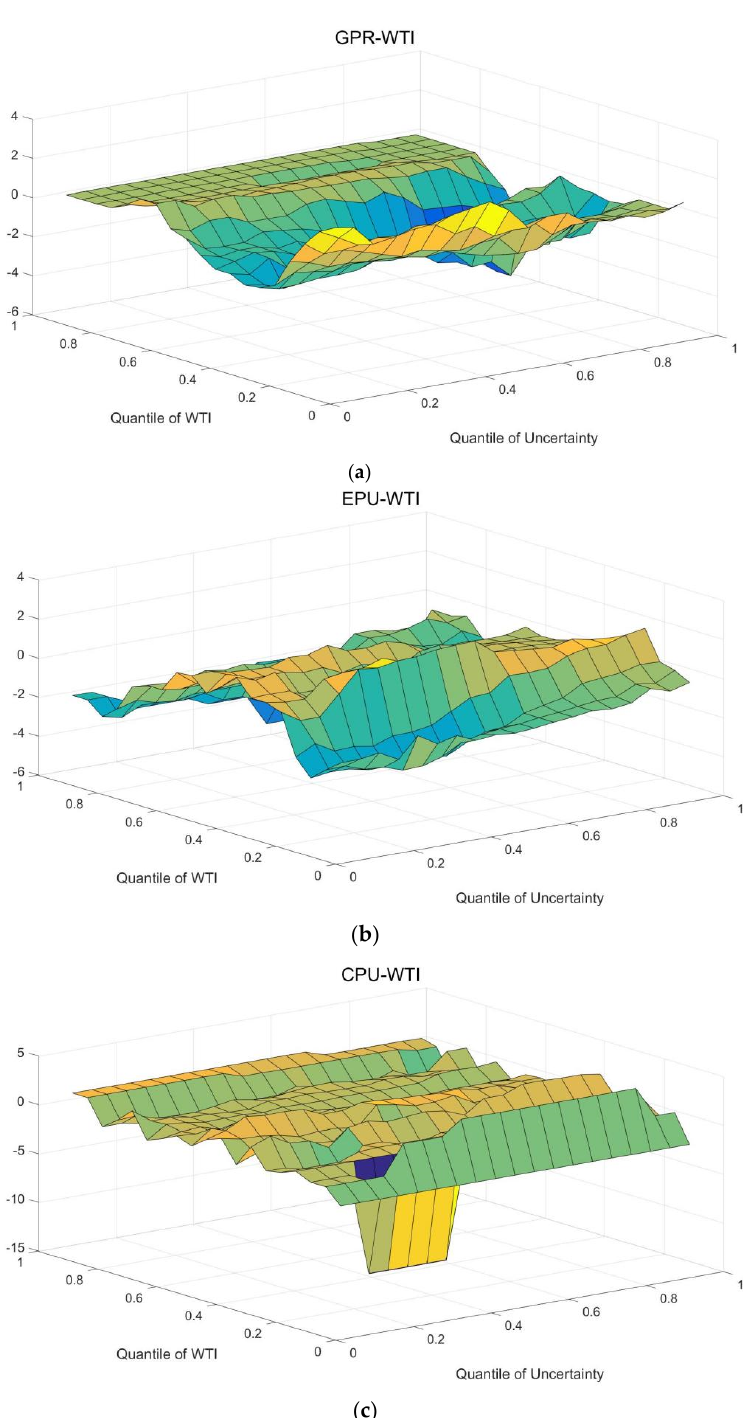
Figure 2. Estimation of the overall impact coefficients of three uncertainties on crude oil price. ( a ) The overall impact of the GPR on the WTI; ( b ) The overall impact of the EPU on the WTI; ( c ) The overall impact of the CPU on the WTI.